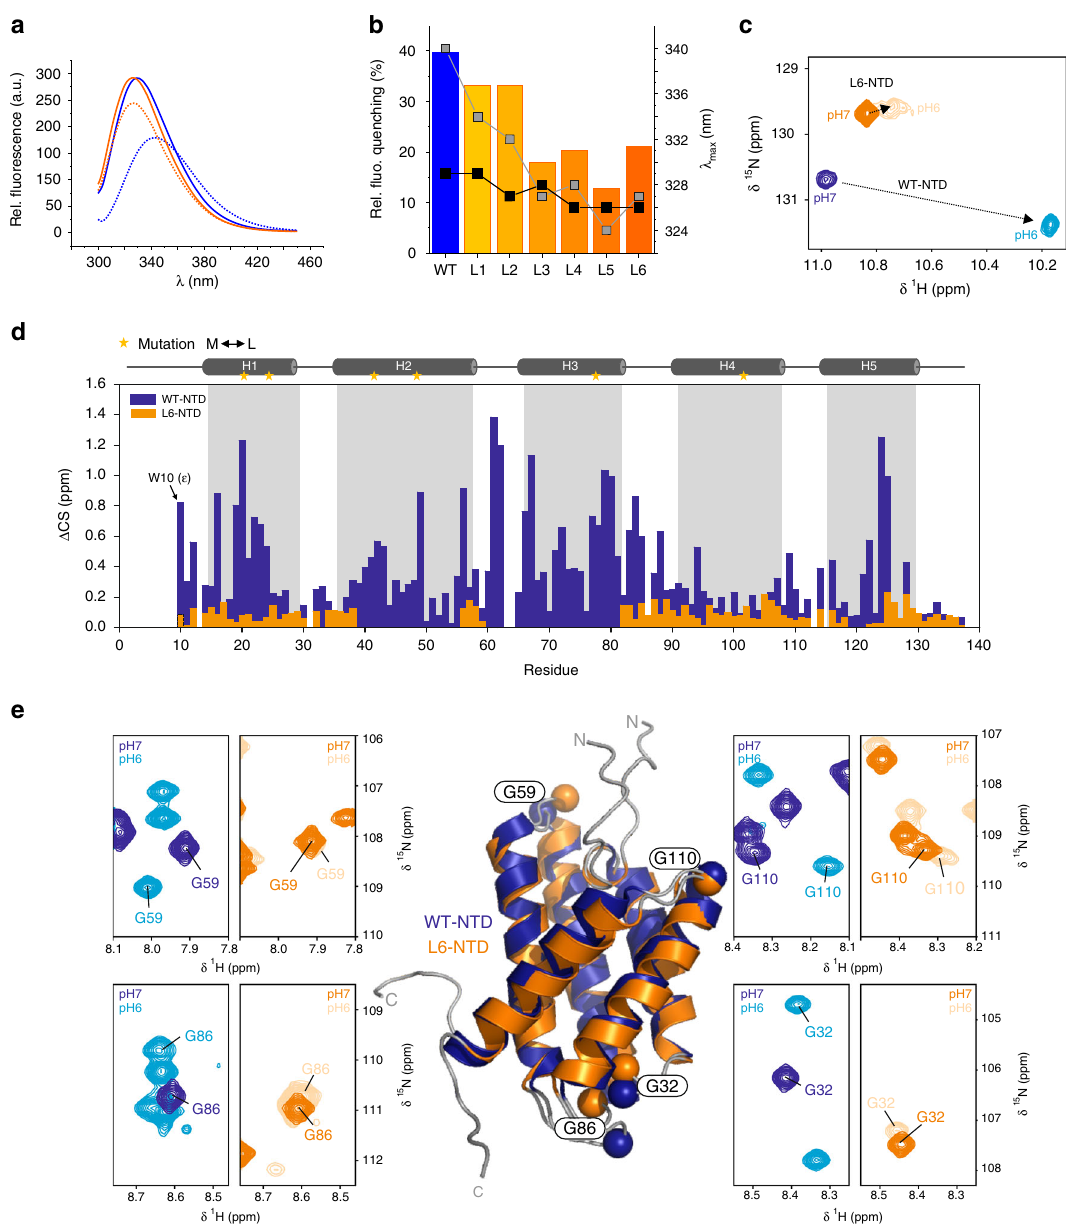
Fig. 5 Native-state conformational changes of the NTD. a Trp fl uorescence spectra of WT-NTD (blue) and L6-NTD (orange) measured at pH 7.0 and 200 mM ionic strength (solid lines), and at pH 6.0 and 8 mM ionic strength (dashed lines). b Quenching of Trp fl uorescence emission of cumulative Met- to-Leu mutants upon change of solution condition from pH 7.0 (200 mM ionic strength) to pH 6.0 (8 mM ionic strength) (colored bars). The wavelengths of maximal fl uorescence emission at pH 7.0 (gray squares) and at pH 6.0 (black squares) is shown for each mutant. c 1 H, 15 N-HSQC NMR spectra detailing the side chain amide signal of W10 of L6-NTD and WT-NTD in pH 7.0 buffered solution and 200 mM ionic strength (orange and blue, respectively) and in pH 6.0 and 8 mM ionic strength (light orange and cyan, respectively). d NMR chemical shift (CS) differences of assigned residues in the WT-NTD (blue) and L6-NTD (orange) upon change of solution pH from 7.0 to 6.0. e 1 H, 15 N-HSQC NMR signals of NTD loop residues. Close up of the HSQC spectral regions of glycine residues G59, G86, G110, and G32 located in loop segments connecting helices of WT-NTD and L6-NTD recorded at pH 7.0 and at pH 6.0 are shown. The location of residues on the aligned structures of WT (blue) and L6-NTD (orange) is highlighted as spheres. Source data are provided as Source Data fi le. Source data shown in panel e are provided in the BMRB (entry: 27683) fl uorescence fl uctuations 17,31,32 . We probed dynamics of the conserved Trp residue (W10), which moves in and out of the fi ve-helix bundle 17 . To this end, we modi fi ed the side-chain thiol of an engineered cysteine introduced at the N-terminus, vicinal to W10 (mutant G3C), using the thiol-reactive fl uorophore AttoOxa11 (Fig. 6e). Motion of W10 from buried to solvent- exposed position lead to contact-induced quenching of the NATURE COMMUNICATIONS| (2019) 10:4378